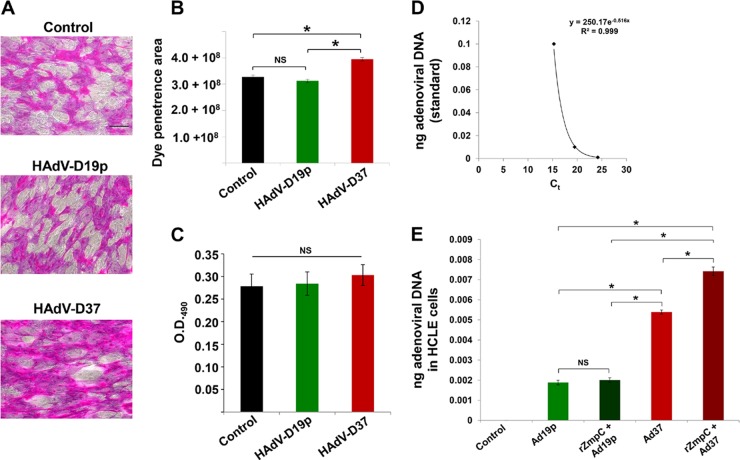
EKC-causing HAdV-D37 decreases glycocalyx barrier function and exhibits increased infectivity of corneal epithelial cells. (A) Representative micrographs of HCLE cells exposed to HAdV-D19p and HAdV-D37 for 2 h and later incubated with rose bengal dye are shown. Control cells were not exposed to HAdV-Ds. Scale bar = 50 µm. (B) Quantitative analyses (n = 30 for each condition) of areas of cells exhibiting rose bengal dye penetrance. *, P < 0.05, Bonferroni test; NS, not significant. (C) Values for optical density at 490 nm (OD490), corresponding to the levels of LDH released into the culture supernatants under the conditions described in the legend to panel A. NS, not significant at a P value of <0.05 by Kruskal-Wallis test. (D) Standard curve generated by plotting the cycle threshold (Ct) required to amplify the E1B gene from known amounts of adenoviral DNA (0.1 ng, 0.01 ng, and 0.001 ng) by qPCR. (E) Quantification of adenoviral DNA recovered from untreated and rZmpC-pretreated HCLE cells that were exposed to HAdV-D19p and HAdV-D37 at identical MOIs for 2 days. The equation resulting from the standard curve shown in panel D was used to quantify adenoviral DNA in HCLE cells. *, P < 0.05, Bonferroni test; NS, not significant.